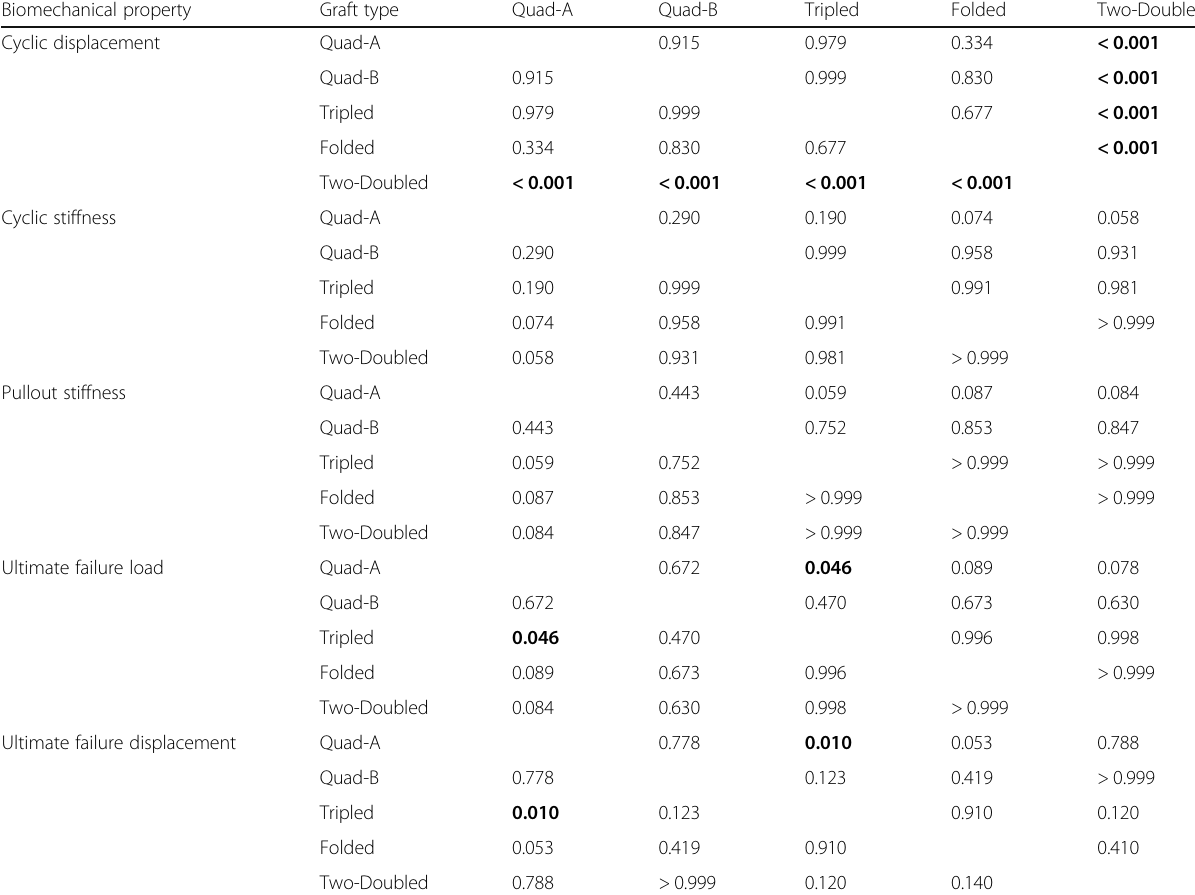
Table 4 Post hoc pairwise comparisons of biomechanical properties Biomechanical property Graft type Cyclic